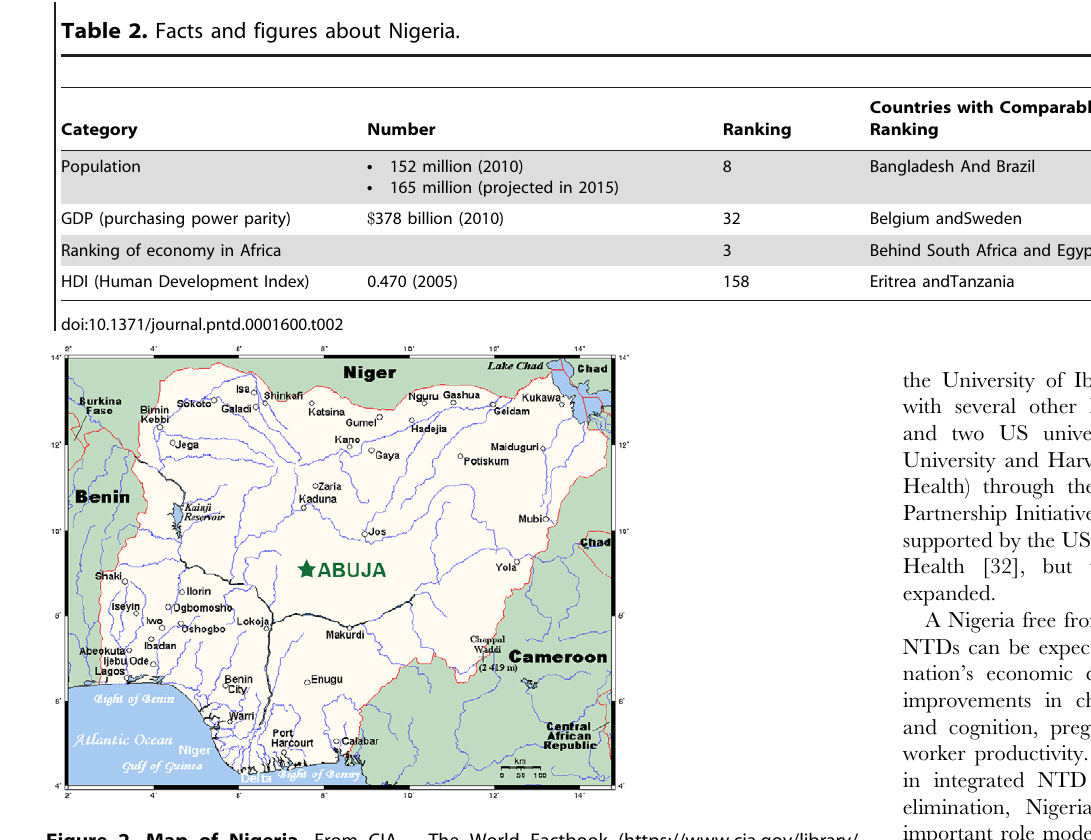
Figure 2. Map of Nigeria. From CIA – The World Factbook (https://www.cia.gov/library/ publications/the-world-factbook/geos/ni.html), accessed 1 February,